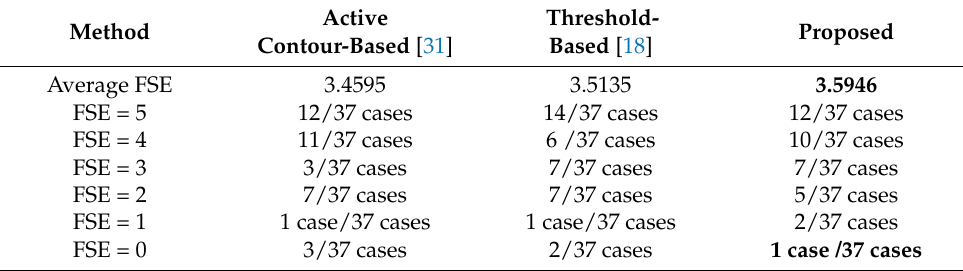
Table 10. Comparison of the results in the TMUEH dataset with the reproduced algorithms by